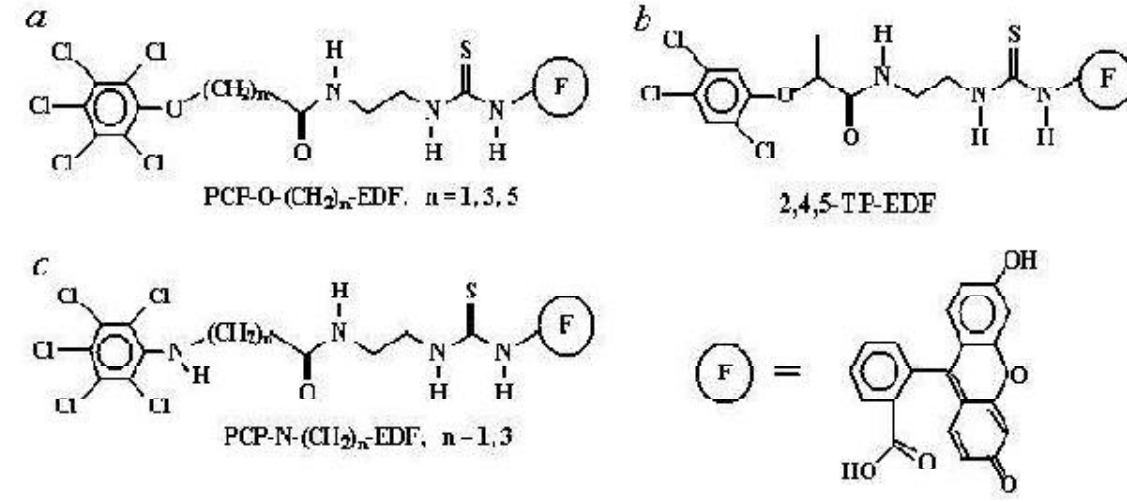
FIGURE 2 . Structure of tracers: (A) homologous tracers with different linker length; (B) amino- substituted tracers with different linker length; (C) heterologous tracer 2,4,5-TP-EDF. F – fluorescein molecule.